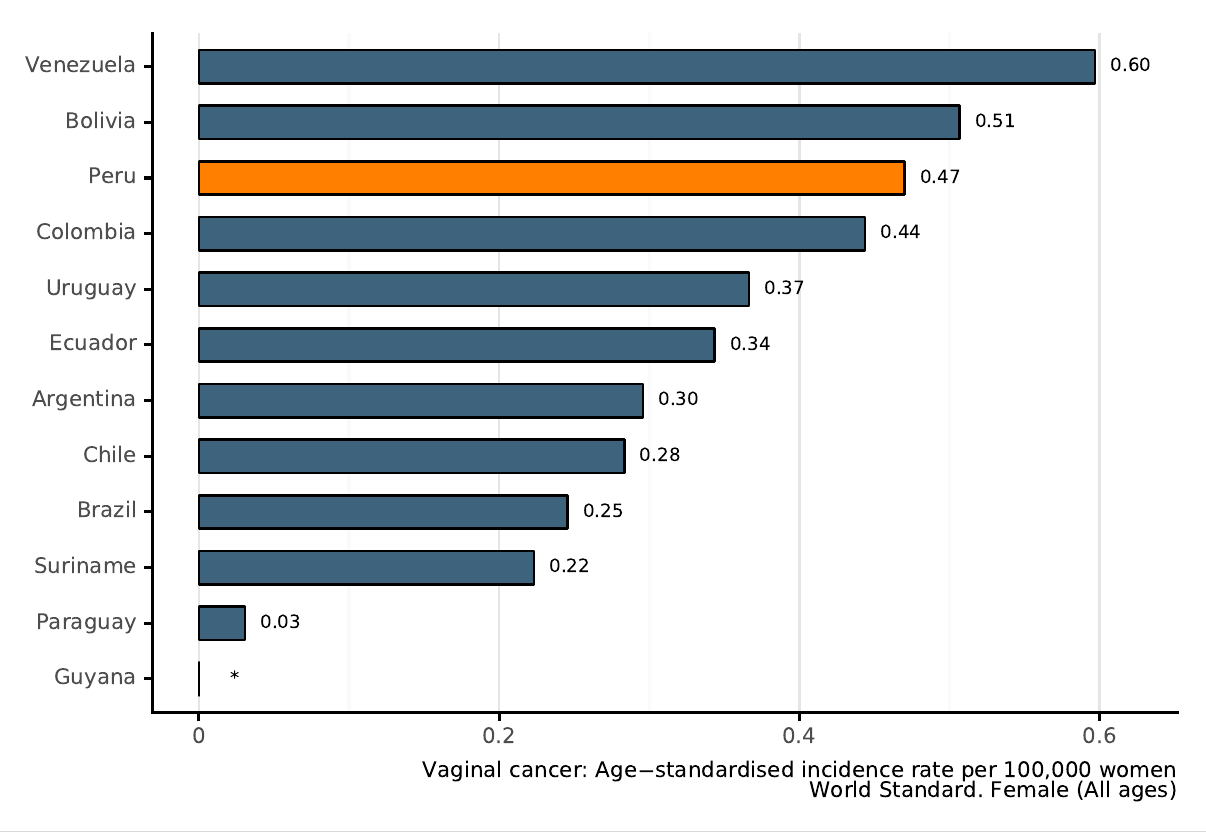
Figure 84: Age-standardised incidence rates of vaginal cancer of Peru (estimates for 2020)